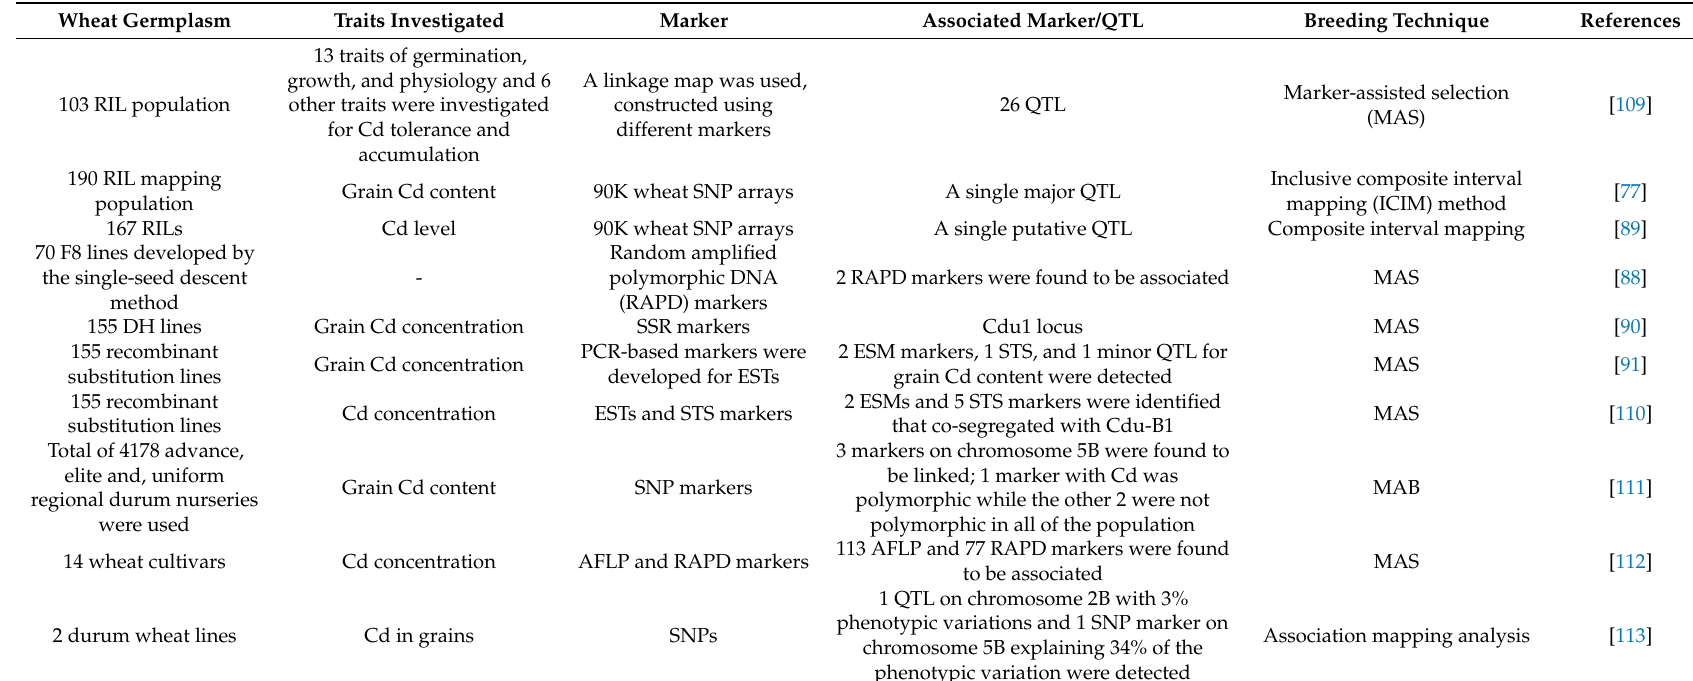
Table 2. Marker genotype and quantitative trait loci (QTL) analysis for low Cd in